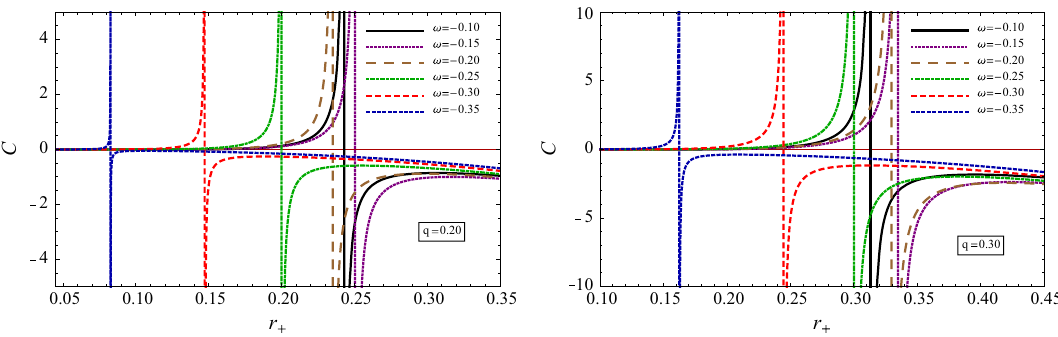
Fig. 5 The specific heat ( C + ) vs. horizon radius r + for the 5D general relativity black hole surrounded by the quintessence matter. The black hole thermodynamically unstable when C + < 0, and stable when C + >